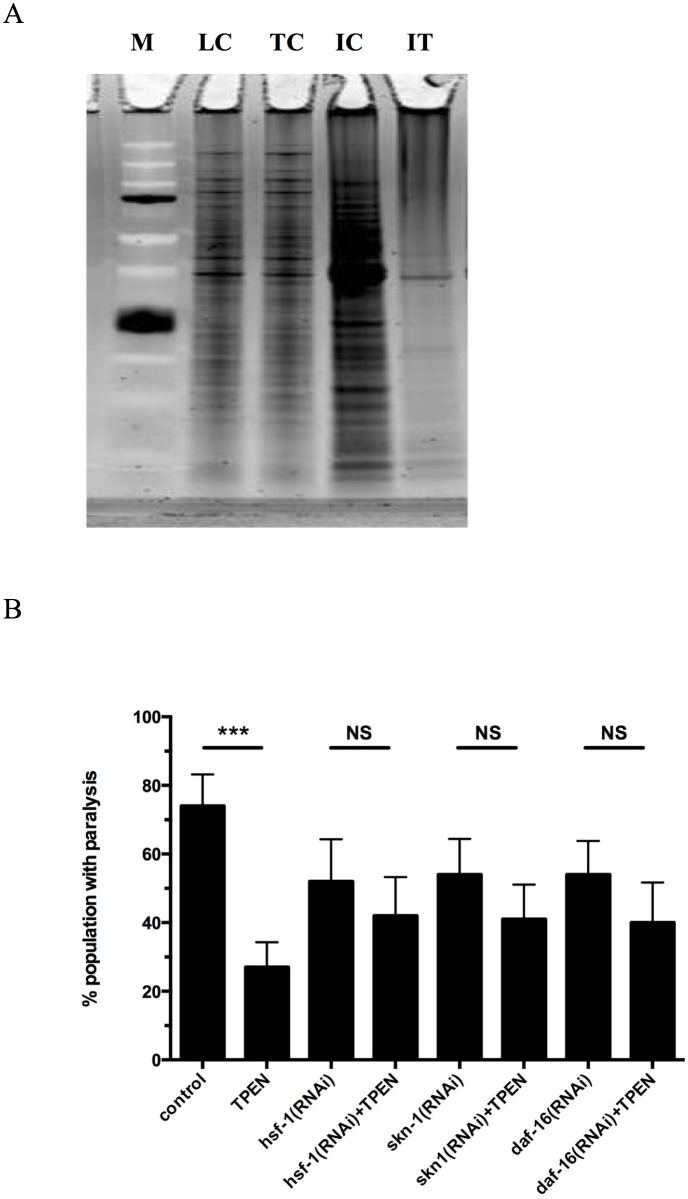
Zinc availability modulates healthspan in C. elegans.(A) Levels of age-related protein aggregation in worm populations exposed to zinc or TPEN. L4 stage TJ1060 [spe-9(hc88)I; fer-15(b26)II] worms were exposed to 500μM ZnSO4 or 200μM TPEN at L3 stage for 6 days and then analyzed for SDS-insoluble protein. The representative experiment shows worms exposed to TPEN had reduced SDS-insoluble protein in comparison with control animals. (M, marker; LC, loading control of control worms; TC, loading control of TPEN treated worms; IC, SDS-insoluble protein of control animals; IT; SDS-insoluble protein of TPEN treated worms.) (B) Percent paralysis of worms with knockdown for specific genes supplemented with or without TPEN. HE250 worms with knockdown for hsf-1(RNAi), skn-1(RNAi), or daf-16(RNAi) and with or without exposure to 200μM TPEN were scored for paralysis after 48 hours. Control worms treated with 200μM TPEN showed significantly less paralysis in comparison to control animals (***, p<0.0001, log rank test). However, TPEN was less effective when used in populations with knockdown in hsf-1, skn-1, or daf-16 genes (NS, not significant).